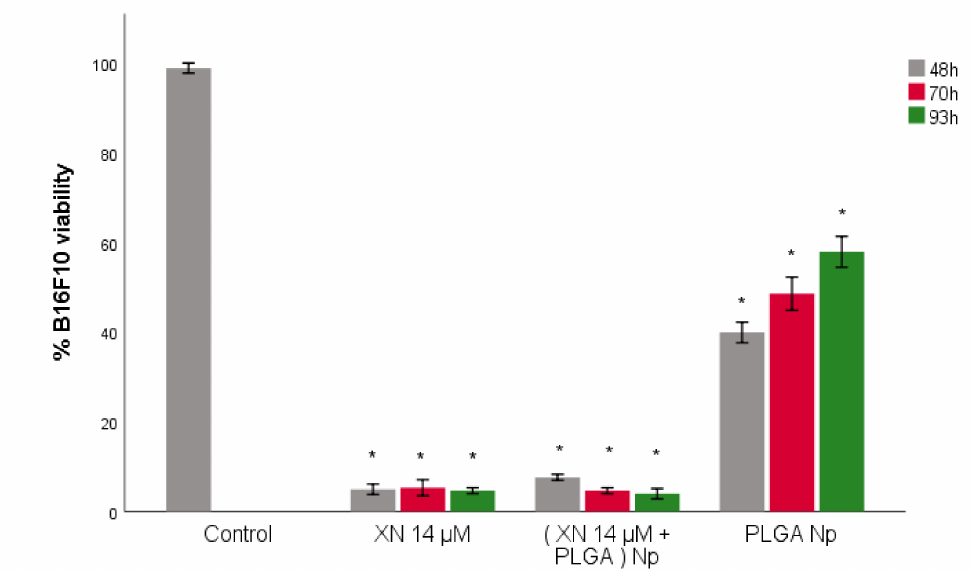
Figure 4. B16F10 viability assay with XN-loaded PLGA nanoparticles compared to XN solubilized form. The control refers to B16F10 incubated with DMEM. “XN”, “Np” and “PLGA” stands for XN, nanoparticles and poly-lactic-co-glycolic acid, respectively. B16F10 viability is expressed in mean percentage ± S.E.M. ( n = 3 for each treatment assay). * Statistically different at a level of p < 0.050 in comparison with the